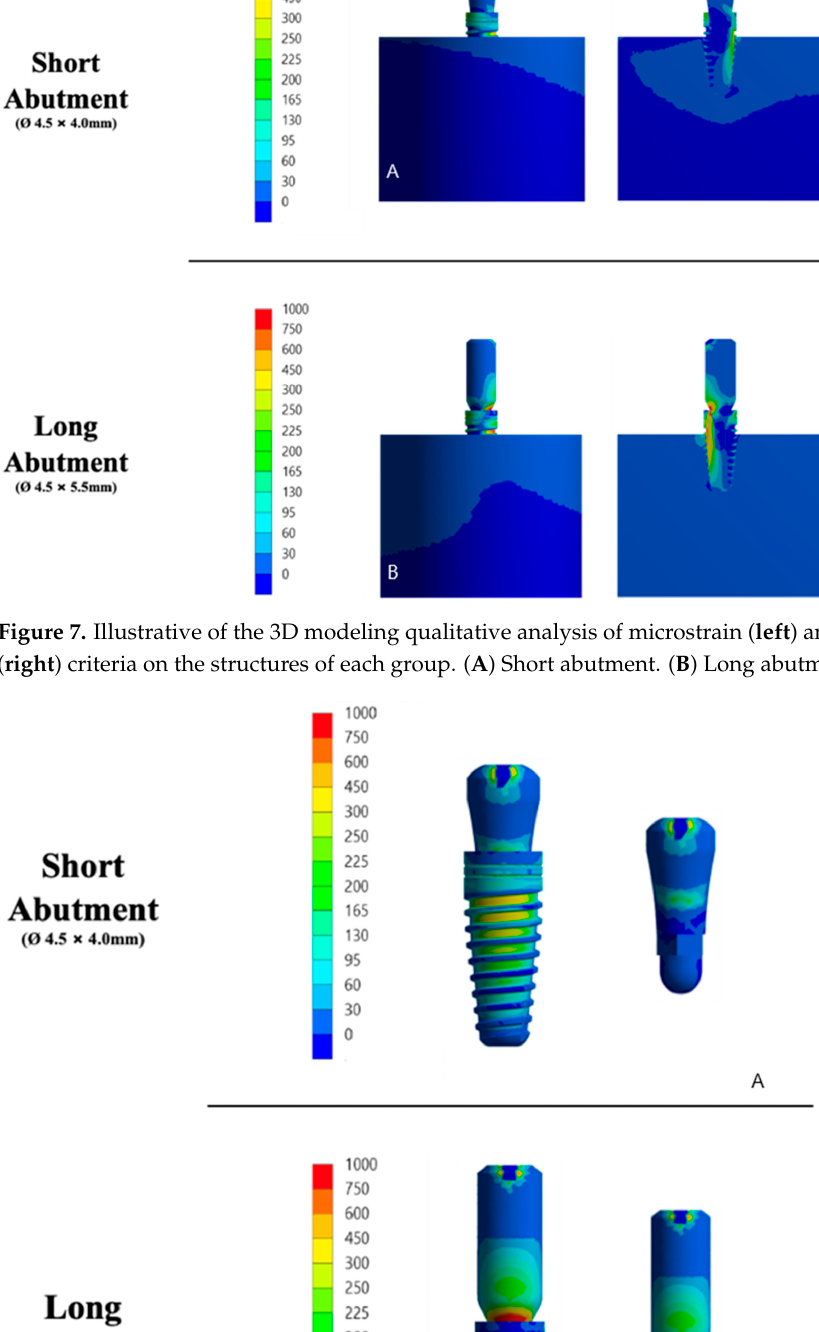
Table 4. Quantitative analysis of von Mises stress results in stress peaks (MPa) in the structures and bone microstrains ( με ) of each group.